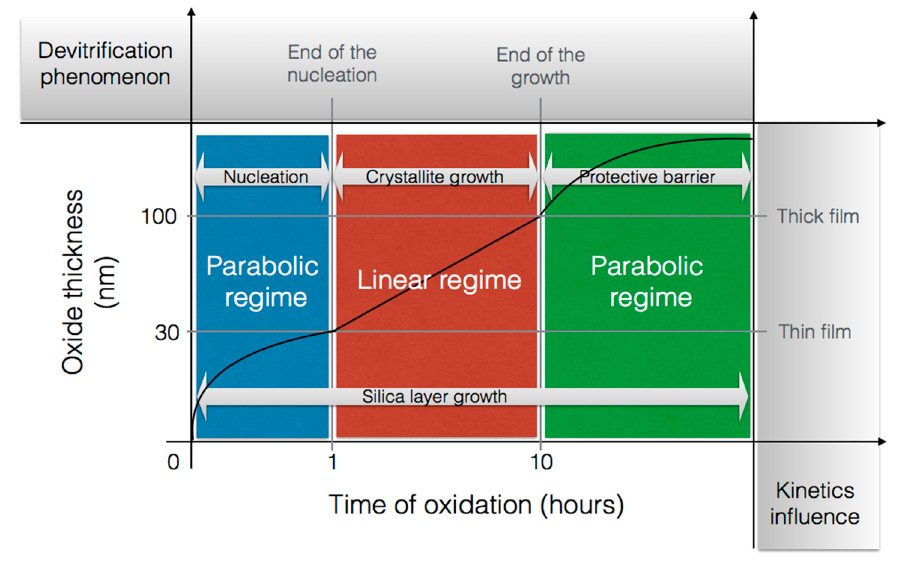
Figure 8. Representation of the kinetics of silica growth and the transition phases of amorphous silica versus time of oxidation in the temperature range of 1000–1300 °C.